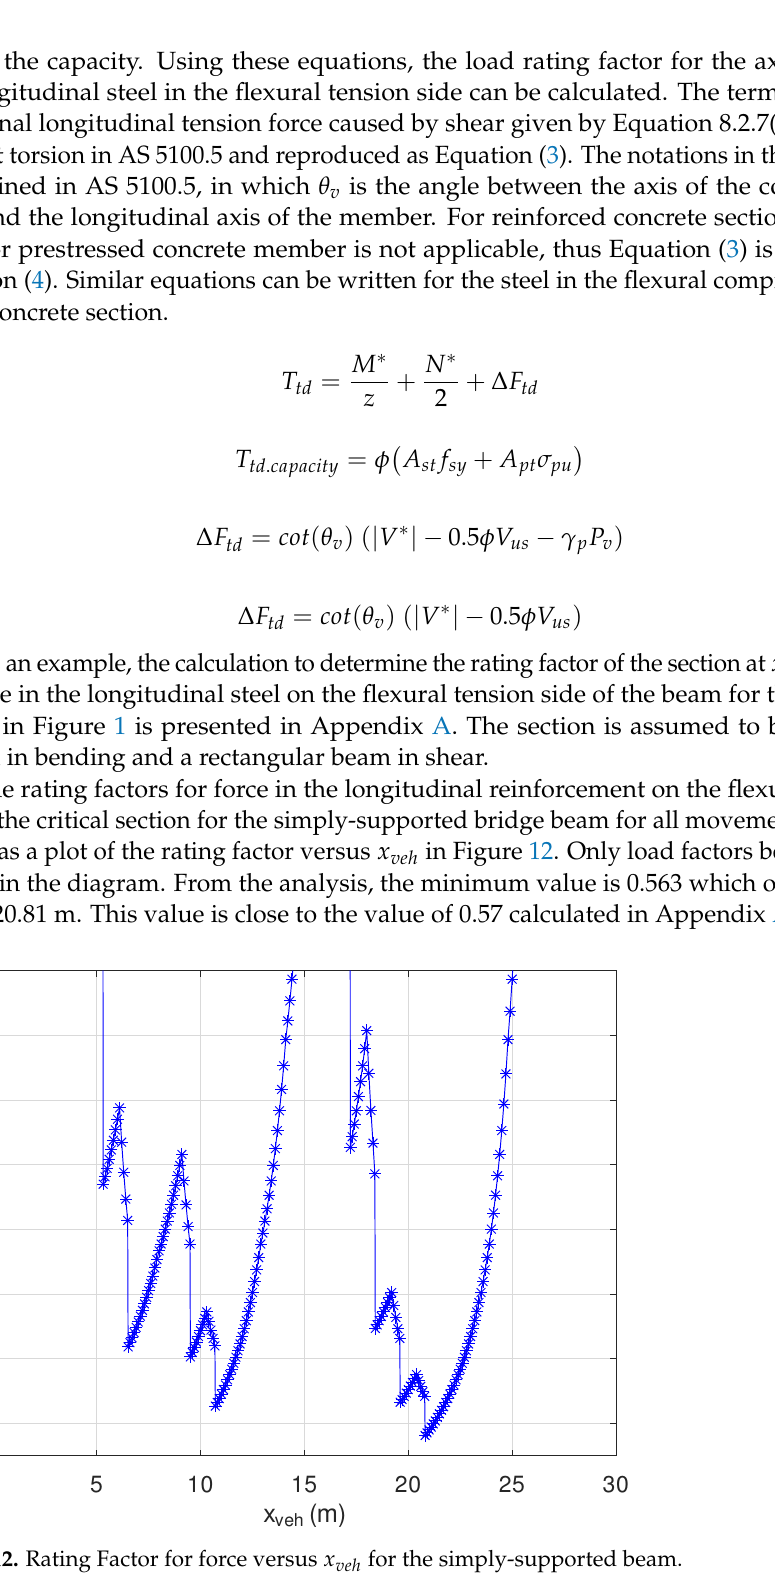
side of the critical section for the two-span bridge beam for all movement steps are shown as a plot of rating factor versus x veh in Figure 13. Only factors below 0.6 are shown in the diagram. From the analysis, the minimum value is 0.225 which occurs when x veh is 18.1